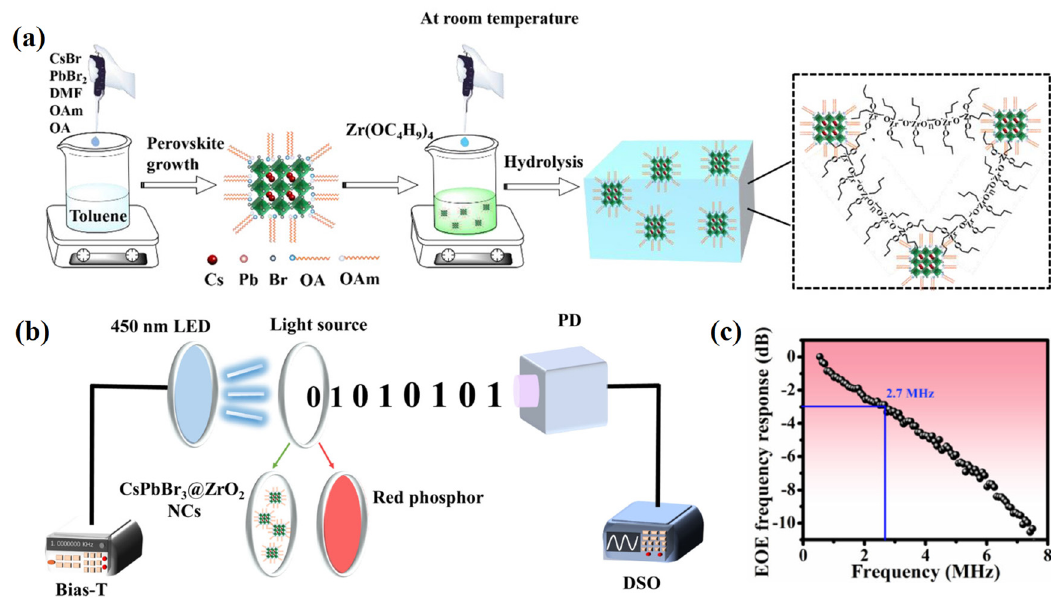
Figure 13: ( a ) Preparation process of CsPbBr 3 @ZrO 2 NCs. ( b ) Schematic diagram and ( c ) frequency response of the VLC system. Reproduced with permission from ref. [ 132 ] . Copyright 2021, Wiley -